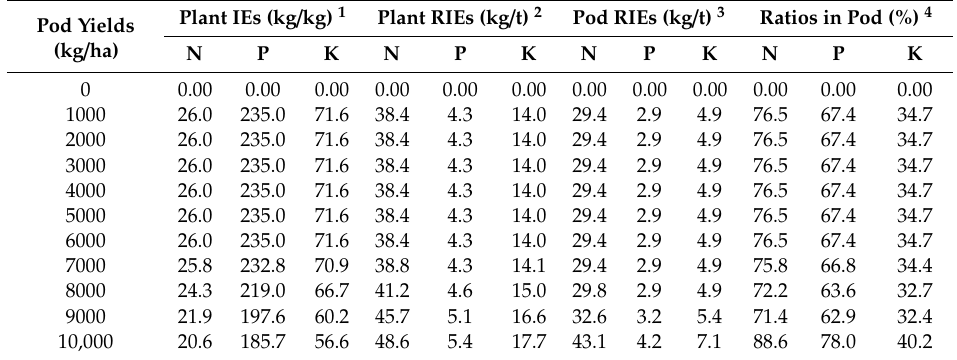
Table 4. Internal e ffi ciency, balanced nutrient requirements of N, P, and K in total plants and pods, and removal ratios at di ff erent targeted pod yields simulated by the QUEFTS model for peanut crops in China with the potential yield set at 10 t / ha.